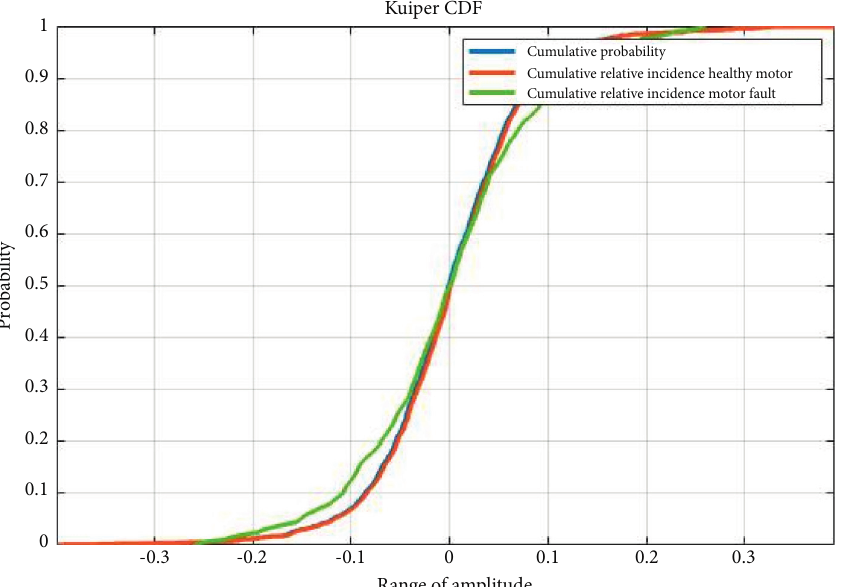
Figure 9: Comparison of the cumulative probability with the cumulative relative frequency of a healthy motor and a faulty motor using the Kuiper test.